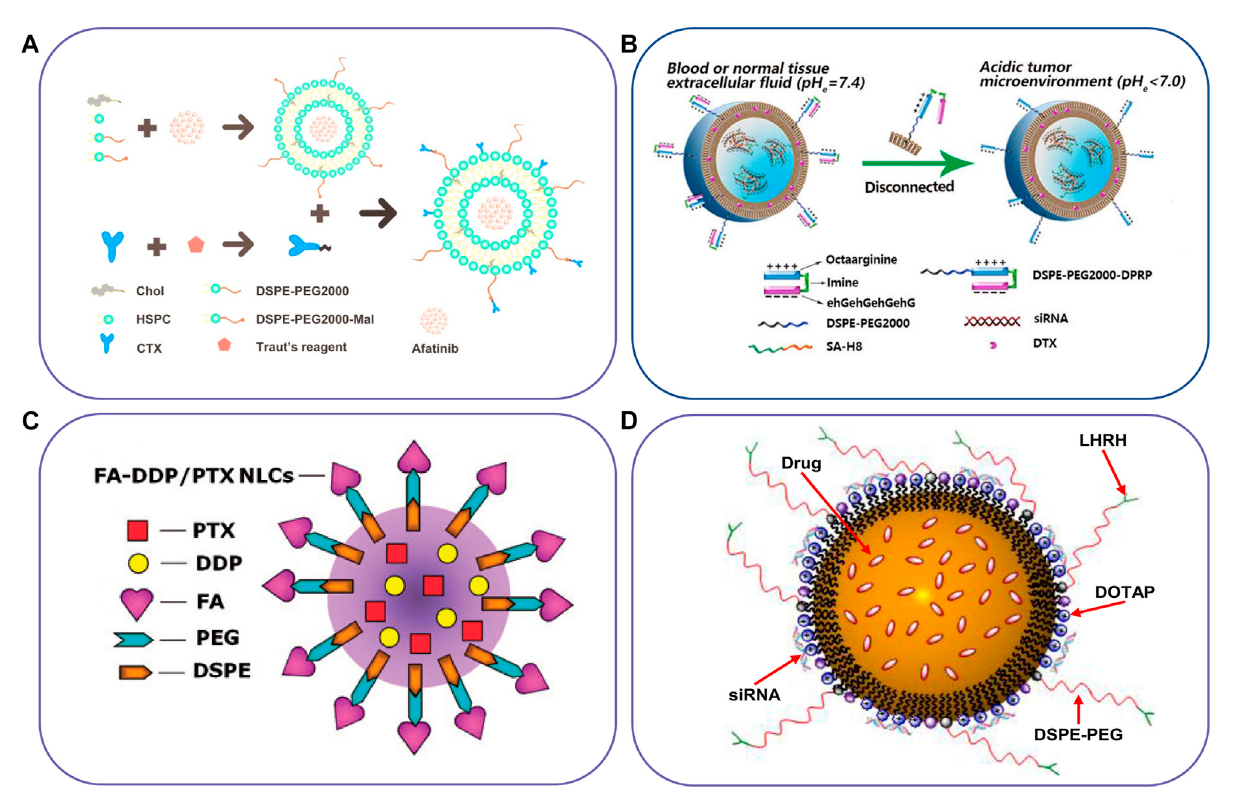
FIGURE 2 Schematicillustrationoflipid-basednanocarrierstoco-delivertwodifferentagents. (A) ImmunoliposometodeliverAFTandCTX, (B) pH-responsive liposome co-delivery DTX and siRNA, (C) FA-targeted NLC for co-delivery of DDP and PTX, and (D) NLC for co-delivery of an anticancer drug, siRNA and targeting peptide. Reproduced with permission from ref. (Lu et al., 2019), (Zhao et al., 2022), (Yang et al., 2016), (Taratula et al., 2013). Copyright 2019, 2022, 2016 and 2013, Elsevier, BioMed Central, Taylor & Francis, and Elsevier,